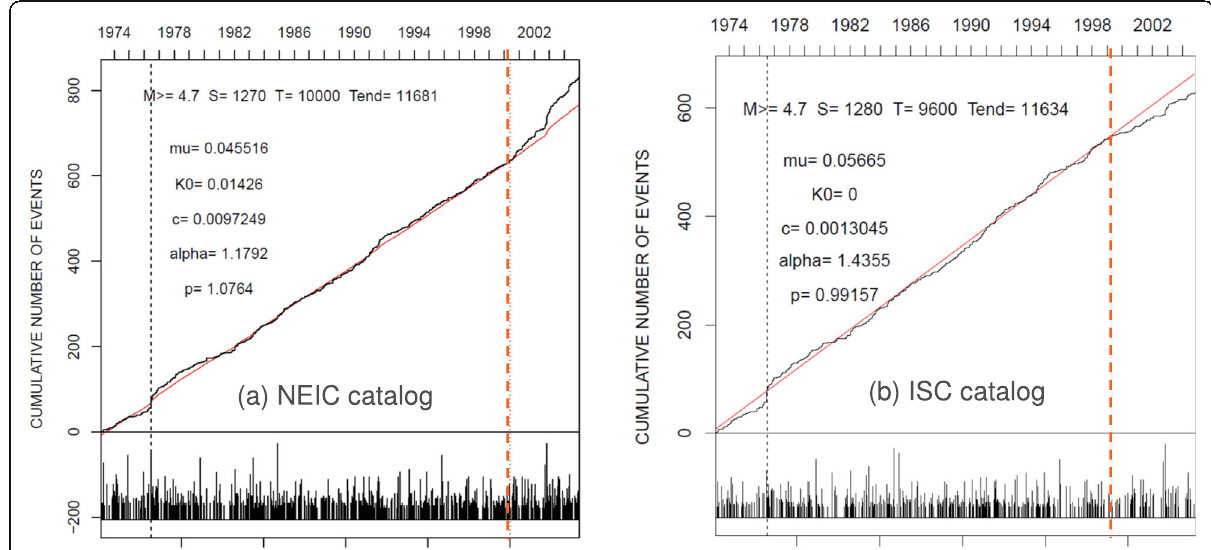
Fig. 2 Opposite seismicity changes between NEIC and ISC catalogs. Estimated cumulative curves of the ETAS model to data from July 1976 until the M9 Smatra earthquake (December 25, 2004) in the Sumatra-Andaman Island region (see text for the region). The data presented are from the period up to the maximum likelihood estimate of change-point (red vertical dashed line for July 18, 2000) and the extrapolated ones to the rest of the period, for the data from a the NEIC PDE catalog and b the ISC